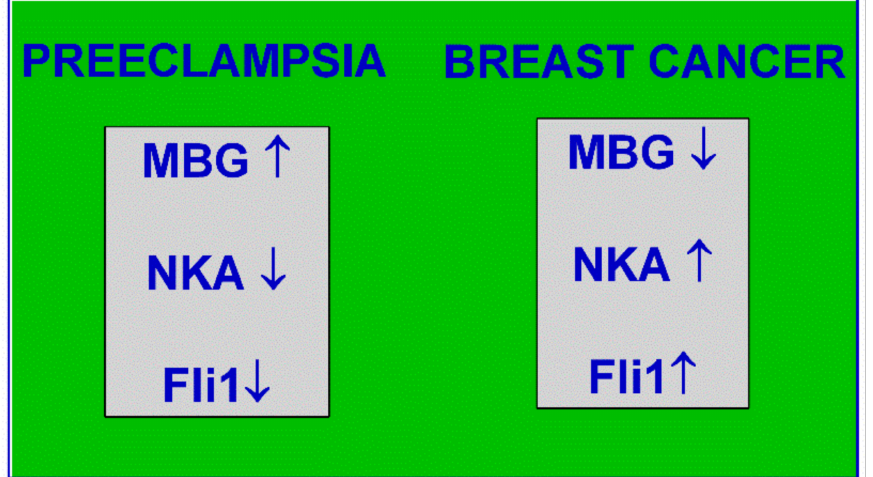
Figure 2. Preeclampsia (left) and breast cancer (right) are associated with different marinobufagenin (MBG)–Na/K-ATPase–Fli1